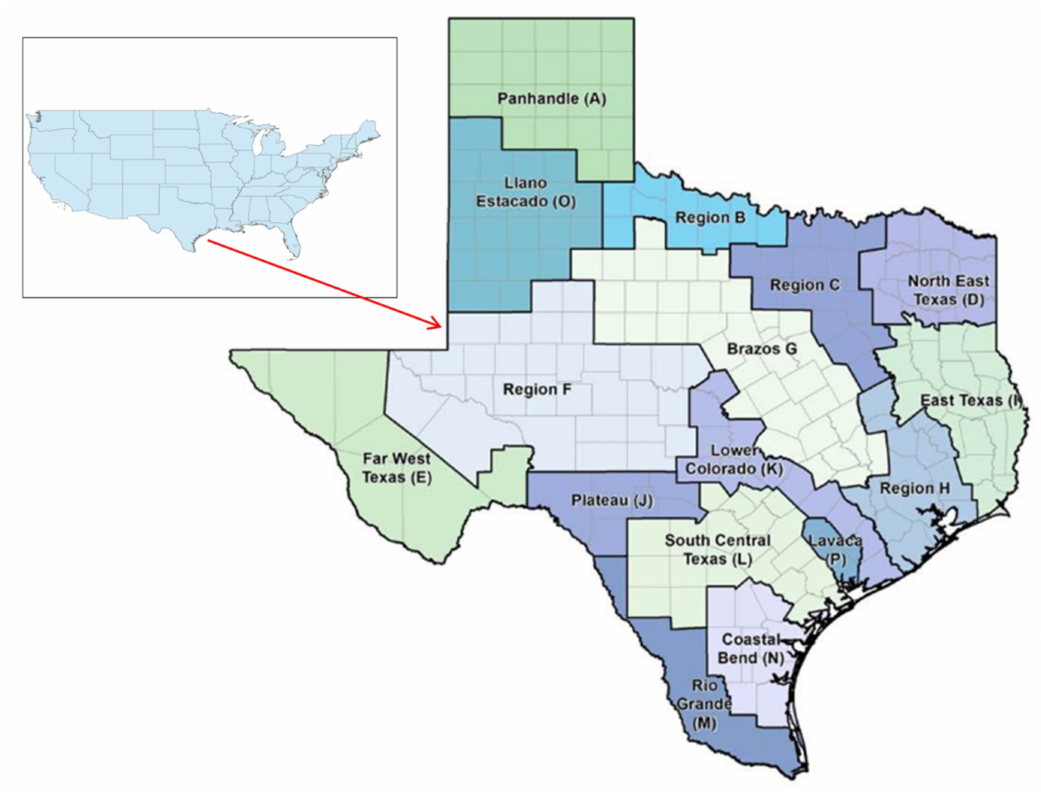
Figure 1. Texas location in the United States and Regional Water Planning Areas in Texas